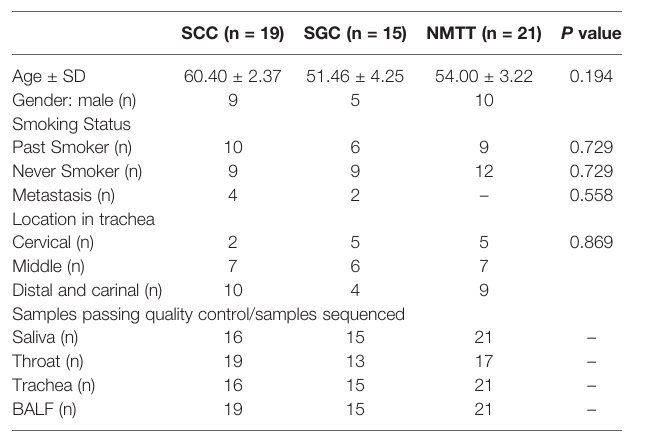
TABLE 1 | Demographic and clinical characteristics of the patients.